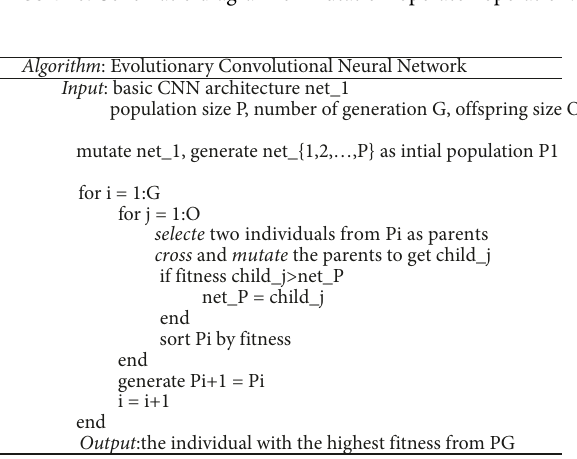
Figure 6: Schematic diagram of mutation operator operation.